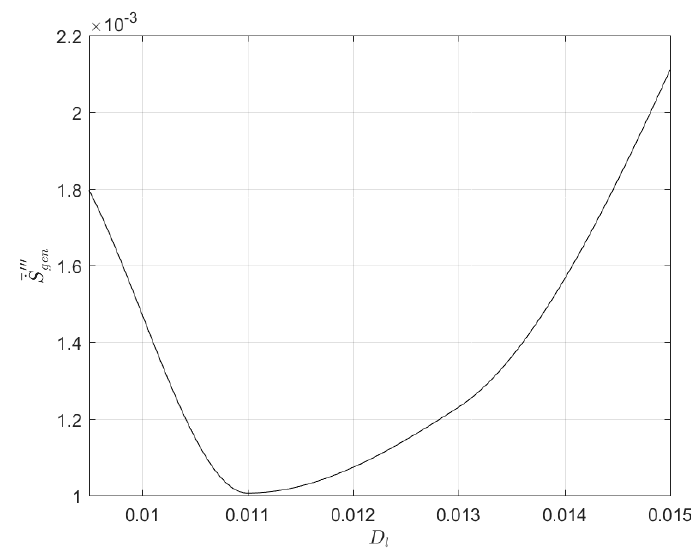
Figure 3. Generated entropy vs. the lamp diameter for N r = 10 and A R = 1/2.